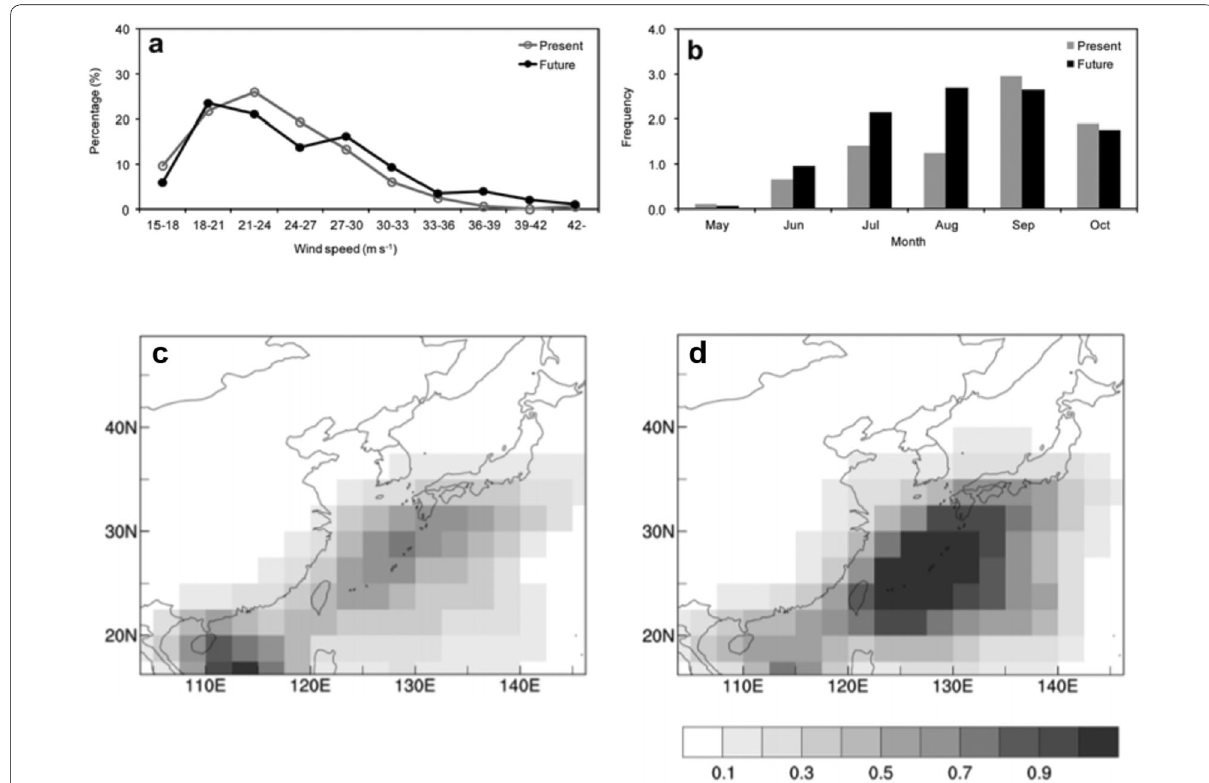
Fig. 4 a Changes in maximum wind speed at 850 hPa around the TC core, b monthly frequency of TC genesis (number/20 years), and track